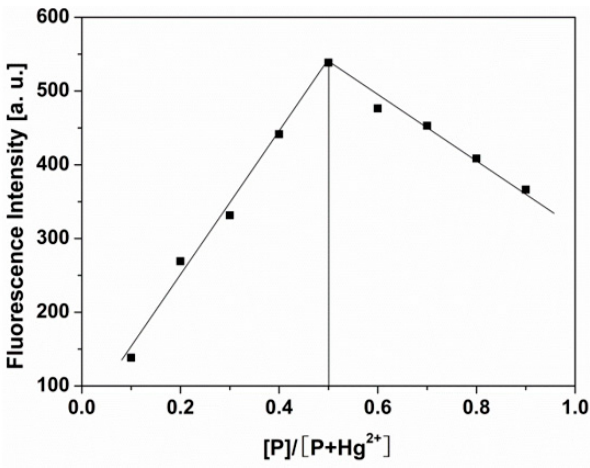
Figure 4. Job’s plot experiment of P with Hg 2+ . Total [ P + Hg 2+ ] was kept at 10 μ M.